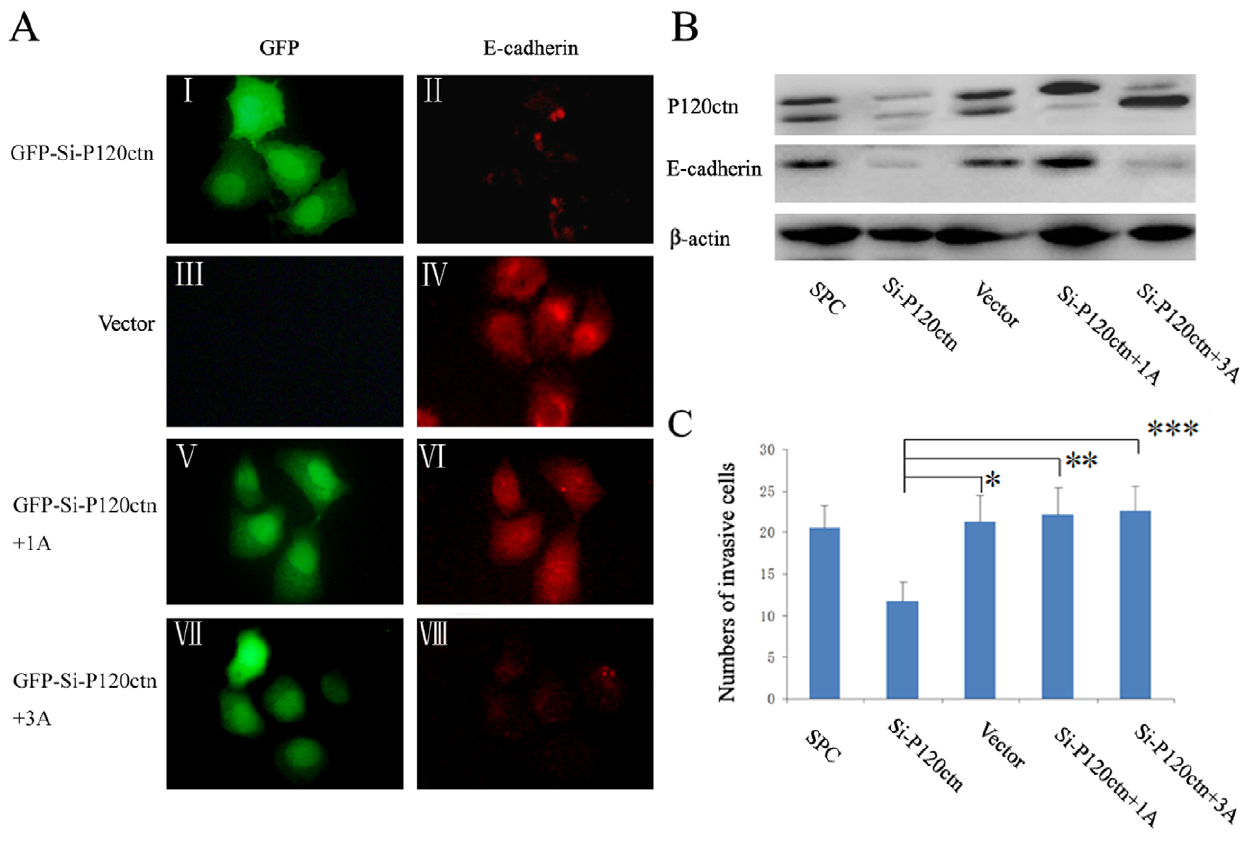
Figure 4. P120ctn isoform 1A restored the cytoplasmic E-cadherin levels and enhanced the invasiveness in SPC cells. SPC cells were transiently transfected with GFP-siRNA-p120ctn or with empty vector as control. 24 hours after transfection, an aliquot of cells was transfected again with p120ctn isoform 1A or 3A cDNA plasmids. ( A ) Levels and localization of E-cadherin were analyzed by immunofluorescence. The green signal shown in the nucleus and cytoplasm indicates effective expression of GFP from GFP-siRNA-P120ctn, confirming the successful transfection. Depletion of p120ctn (I) reduced the E-cadherin levels (II). Transfection with empty vector (III) did not affect the E-cadherin levels (IV). Restitution of p120ctn isoform 1A (V) restored the cytoplasmic E-cadherin levels (VI), while restitution of p120ctn isoform 3A (VII) had no effects on the E-cadherin levels (VIII). ( B ) Levels of E-cadherin were then analyzed by Western blot assay. The results confirmed that depletion of p120ctn resulted in decreased E- cadherin levels. Restitution of p120ctn isoform 1A restored the E-cadherin levels, while restitution of p120ctn isoform 3A had no effects on E-cadherin expression. ( C ) The invasiveness of SPC cells were analyzed by Matrigel invasion assay. P120ctn ablation reduced the cell invasiveness in comparison with the control group transfected with vector alone (*, P , 0.01). Restitution of p120ctn isoform 1A and 3A both enhanced the invasiveness of SPC cells in comparison with the group with p120ctn ablation (Si-p120ctn) (**, P , 0.01, ***, P , 0.01).